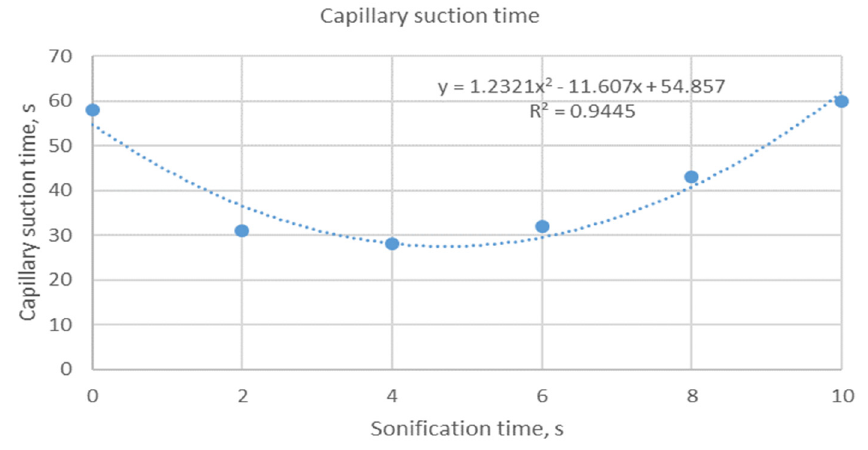
Figure 3. Capillary suction time of sewage sludge conditioned with sonicated polyelectrolyte.